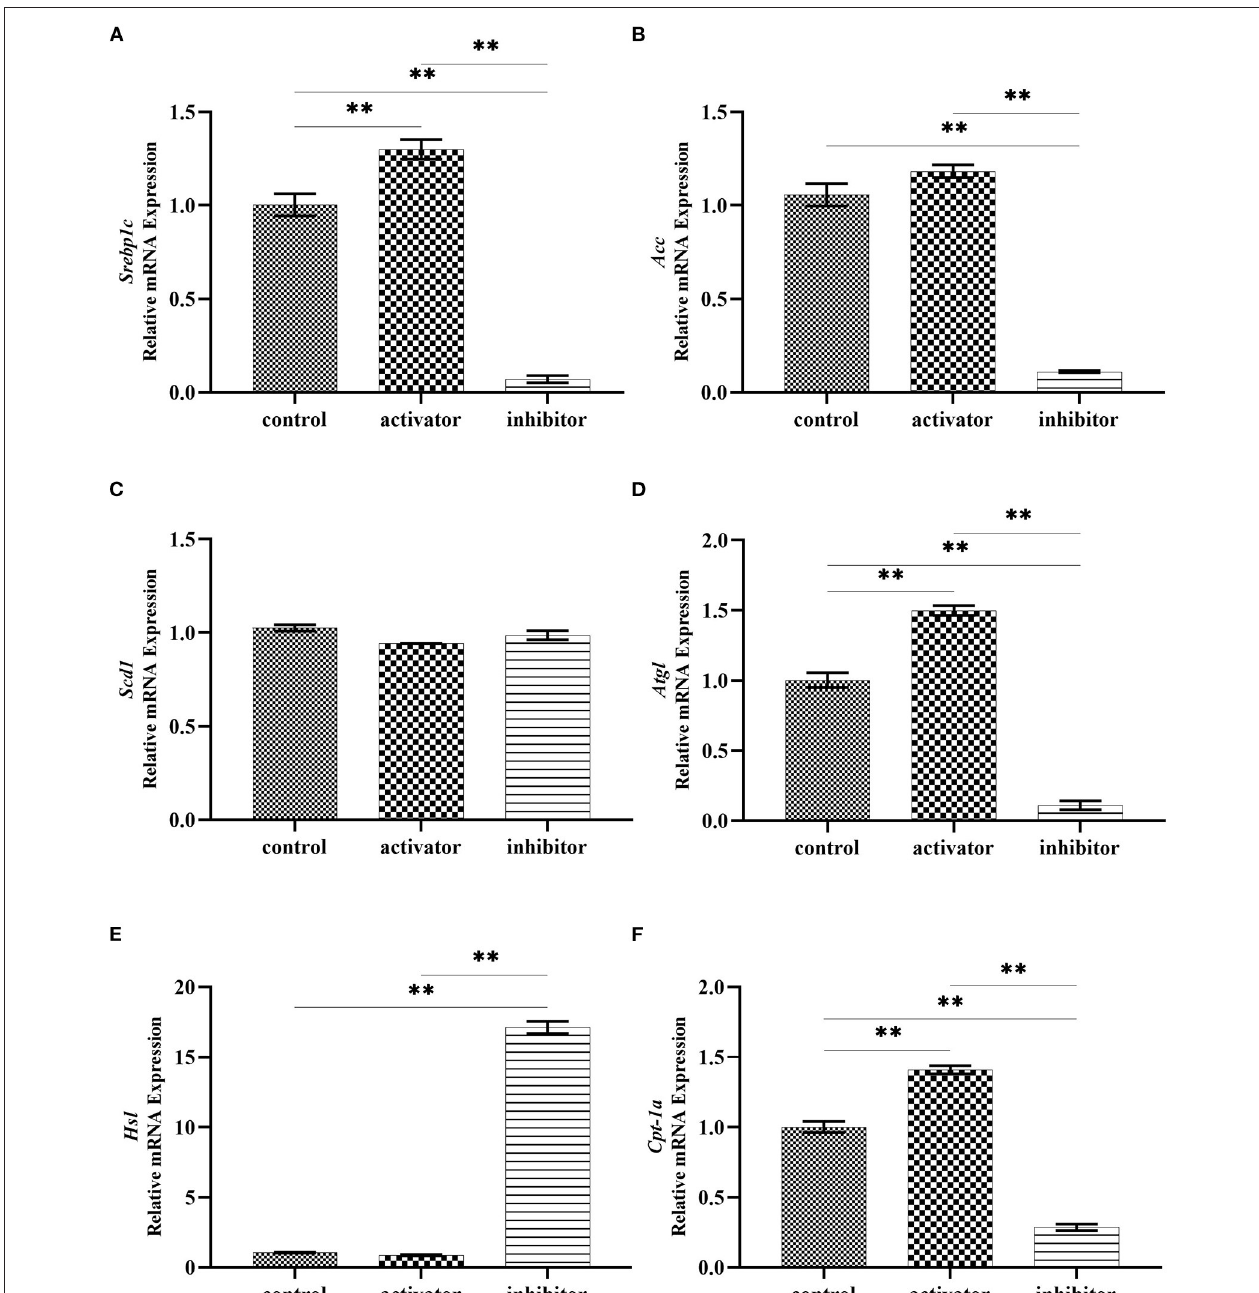
FIGURE 5 | Effects of AMPK activity on the expression of lipid synthesis and decomposition related genes. (A–C) mRNA expression of genes related to lipid synthesis in Acadesine-treated and Dorsomorphin-treated AML12 cells. (D–F) mRNA expression of genes related to lipid decomposition in Acadesine-treated and Dorsomorphin-treated AML12 cells. β -actin was used as the internal control. Data were analyzed by t-test. ** P <